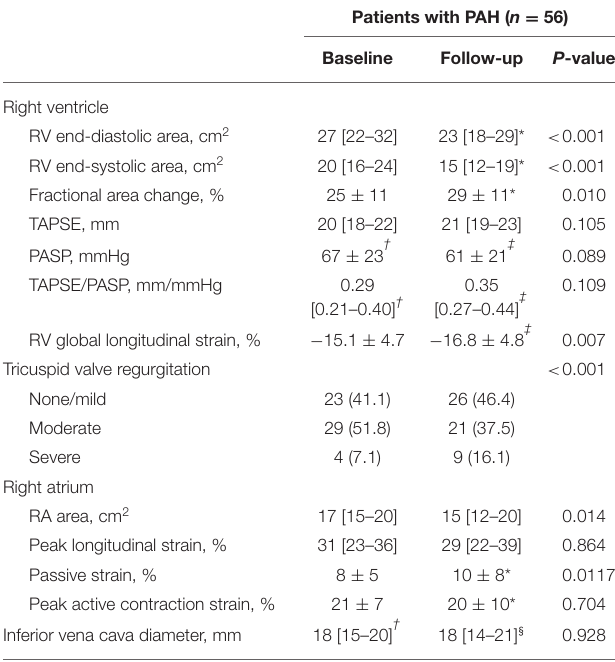
TABLE 2 | Echocardiographic measurements.